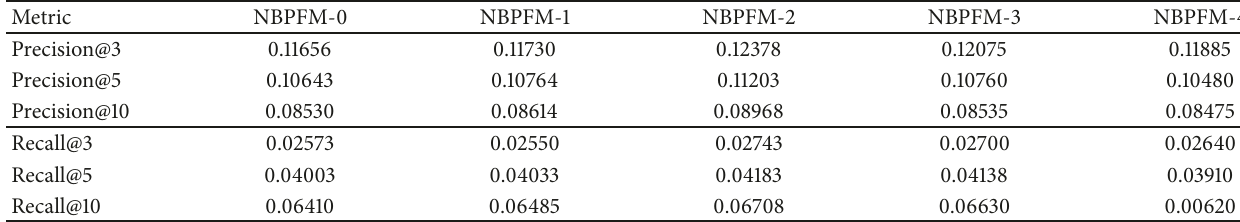
Table 4: Performance of NBPFM with different hidden layers on